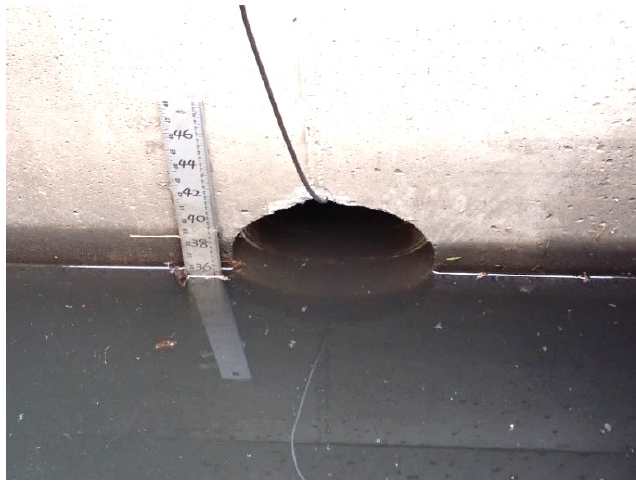
Figure 3. Ponding in the inlet structure due to partial clogging of the distribution pipe (Date: 30 March 2017).